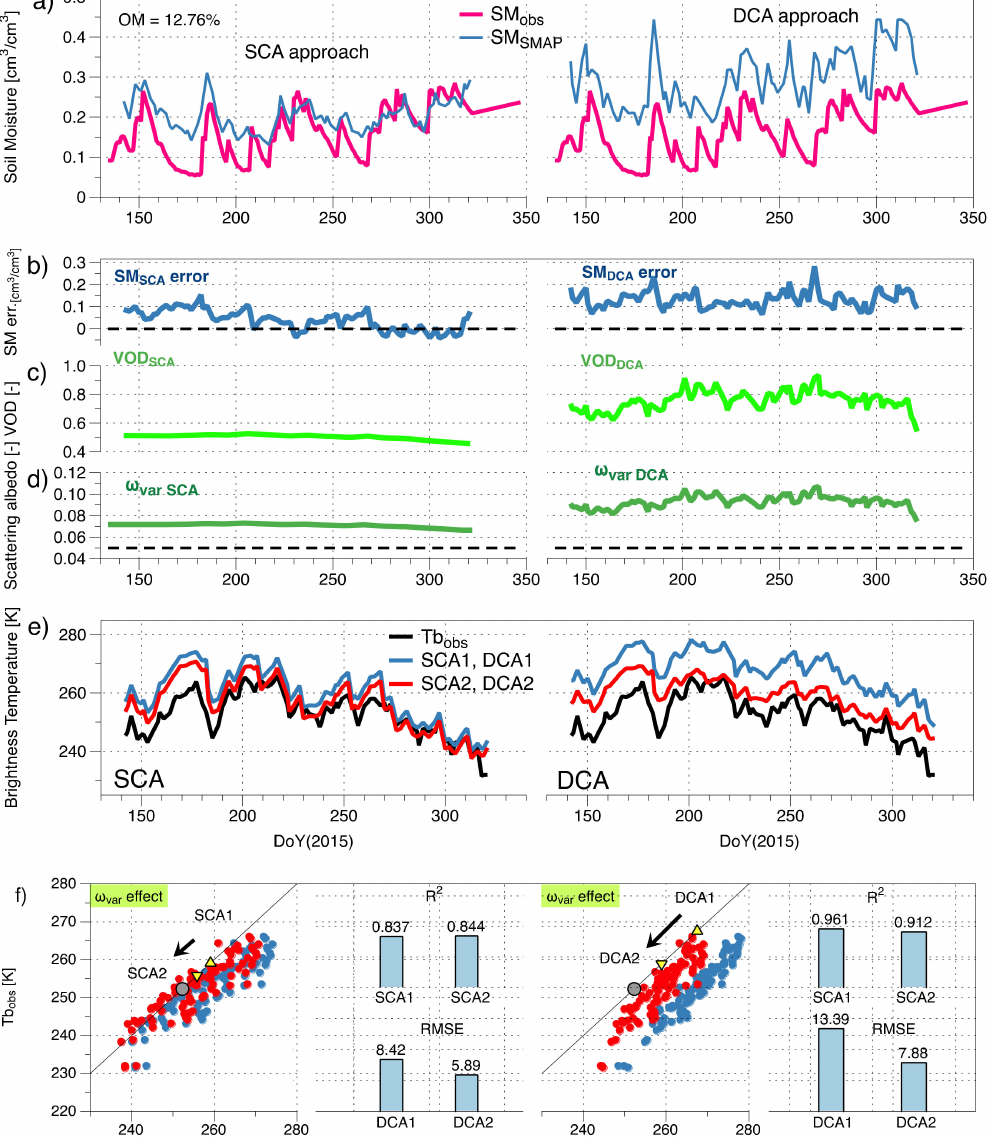
Figure 4. Validation of the improvement by applying time-varying ω within SCA and DCA approaches; ( a ) the soil moisture estimation by SCA (left) and DCA (right), ( b ) their uncertainty, ( c ) SCA and DCA VOD, ( d ) the constant adapted by the SMAP algorithm and the proposed time-varying ω . ( e ) The brightness temperature simulated by τ - ω model applied with the constant and time-varying ω from ( d ) and the input of the in-situ soil moisture presented in ( a ) in USCRN Gadsden-19-N (crop type: soybean). ( f ) (cid:78) : mean SCA and DCA1, (cid:72) : mean SCA and DCA2, • : mean SMAP Tb measurements, → : direction of change from mean SCA and DCA1 to SCA and DCA2 towards the reference Tb